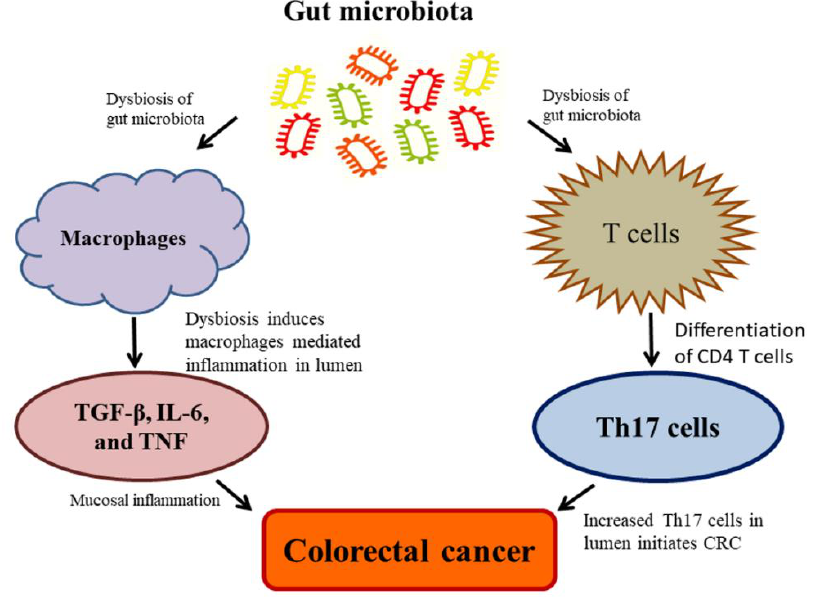
Figure 4. Dysbiosis of gut microbiota causes a high risk of colorectal cancer (CRC).